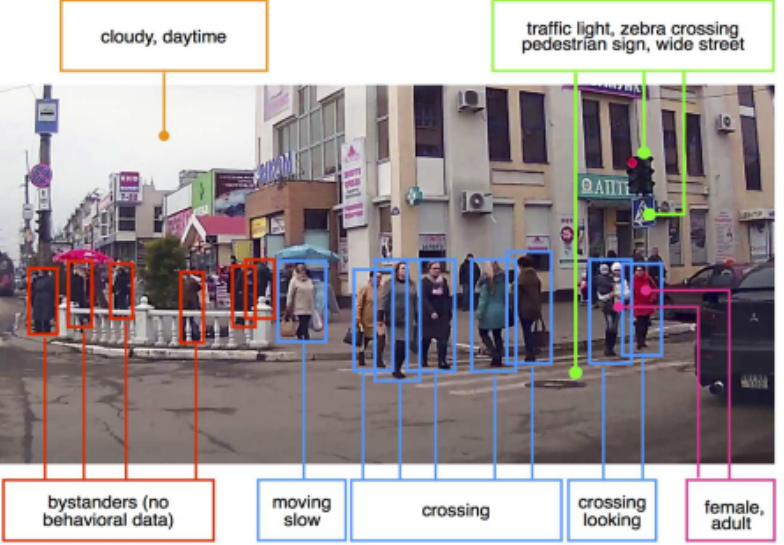
Figure 5. Cluttered road scene with extensive annotation setting that includes bounding boxes for all events, behaviors, and objects information along with the contextual labels